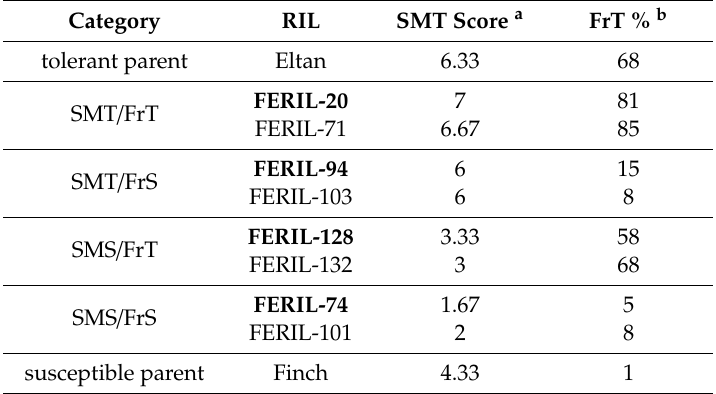
SMS / FrS susceptible parent Finch 4.33